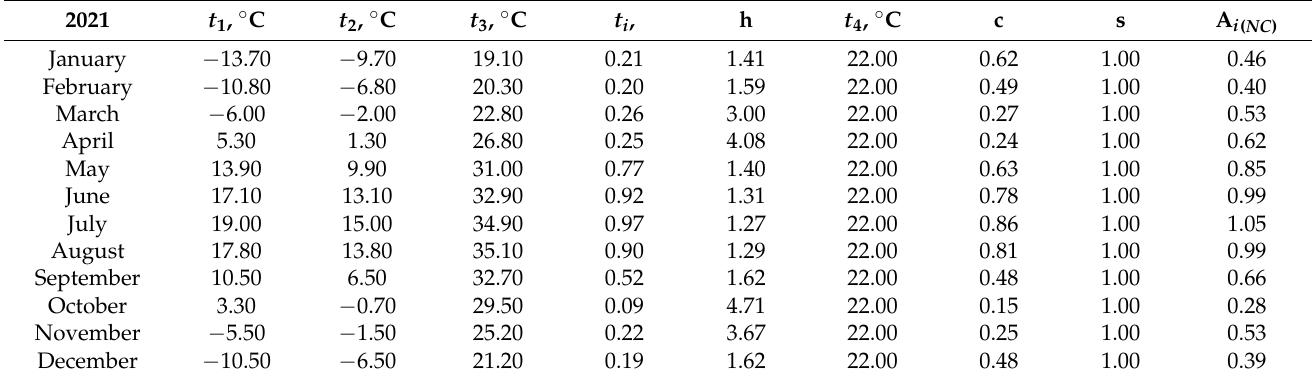
Table 2. The calculated values of the generalized uncertainty coefficient for the first object.